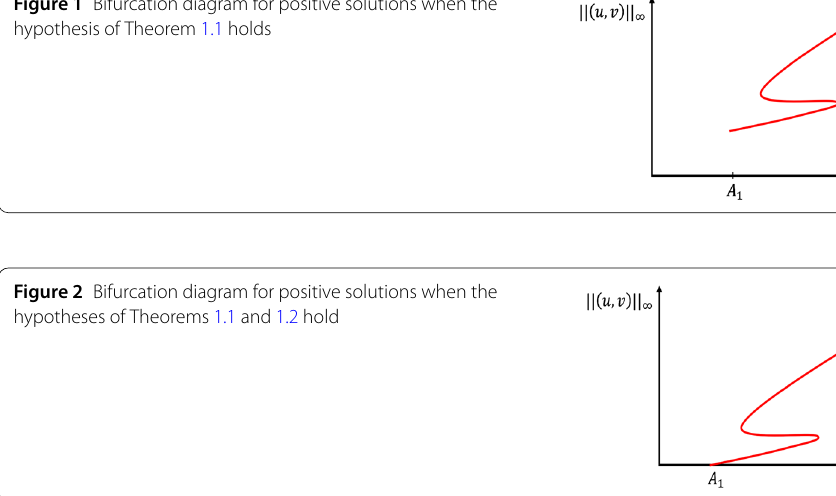
Figure 1 Bifurcation diagram for positive solutions when the hypothesis of Theorem 1.1 holds